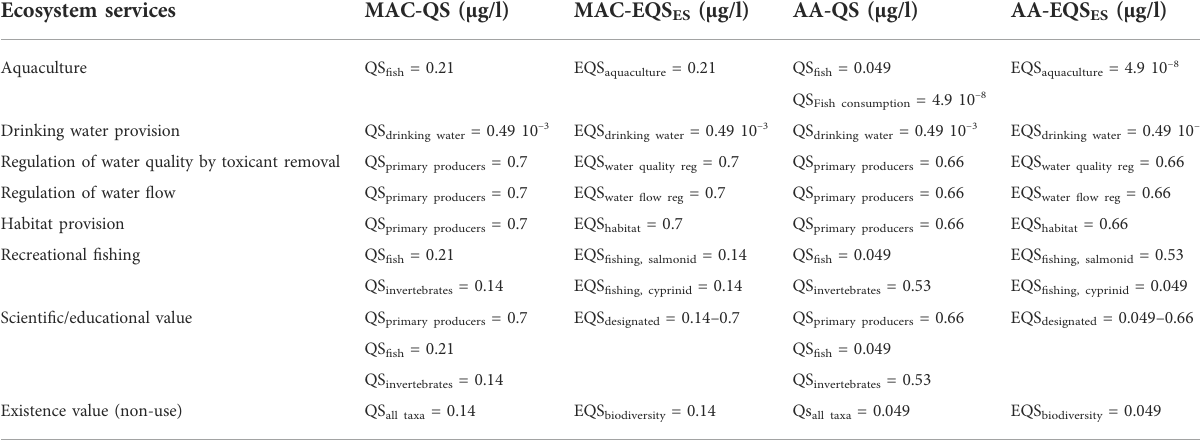
TABLE 6 Service provider quality standards (QS) and ecosystem services-speci fi c EQS values for PBDE. Maximum acceptable concentration (MAC) standards are based on acute data and annual average (AA) standards are based on chronic data. Ecosystem